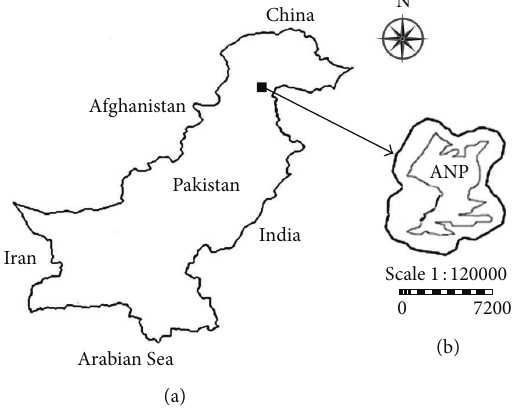
Figure 1: Map of the study area. (a) Pakistan and the location of the study region. (b) The study region with the Ayubia National Park(ANP)boundary(insideboundary)anditssurroundingforests (outside